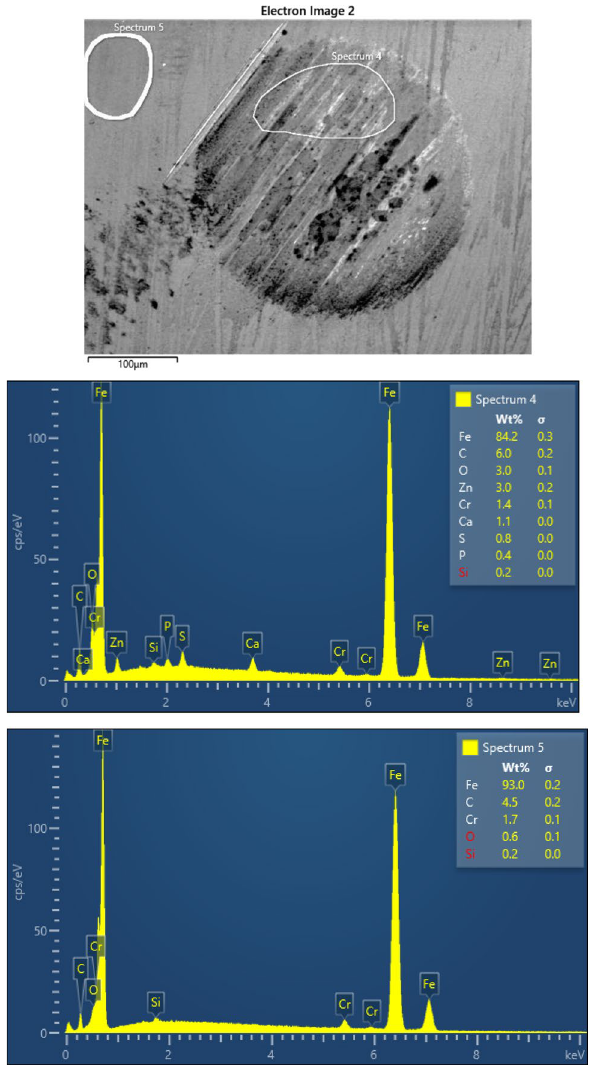
Figure 9. SEM and EDS analysis of worn surface of steel ball after four-ball test lubricated by the oil-added 0.075 wt.% TiO 2 nanoparticles at 75